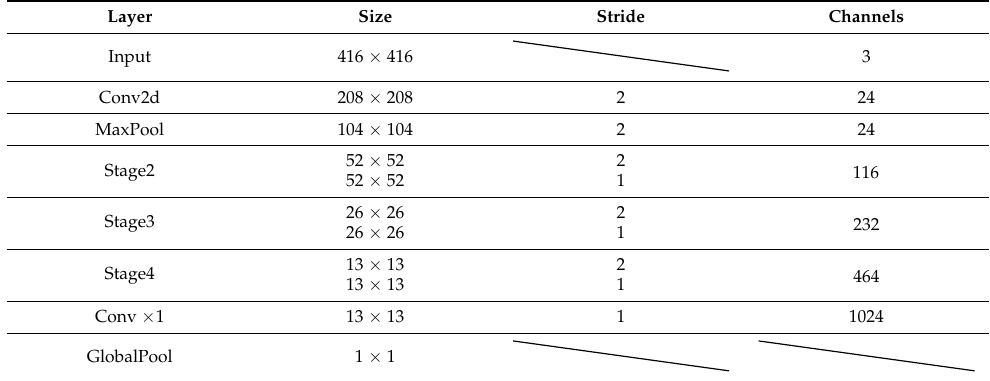
Table 2. Overall structure of ShuffleNetv2. feature layer for down-sampling.